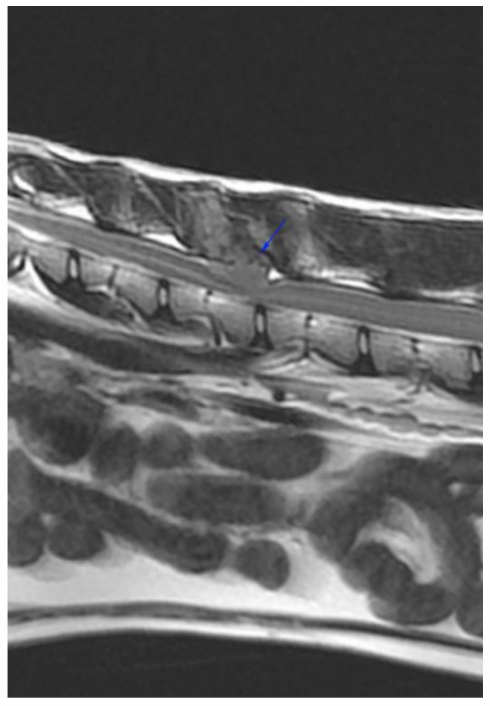
Figure 5. Sagittal T2W image of the spine showing the compression of the spinal cord by the extradural mass, which invades the dorsal lamina and spinous process of L2 (blue arrow). Note the dilation of the central canal and the hyperintensity of the spinal cord around the